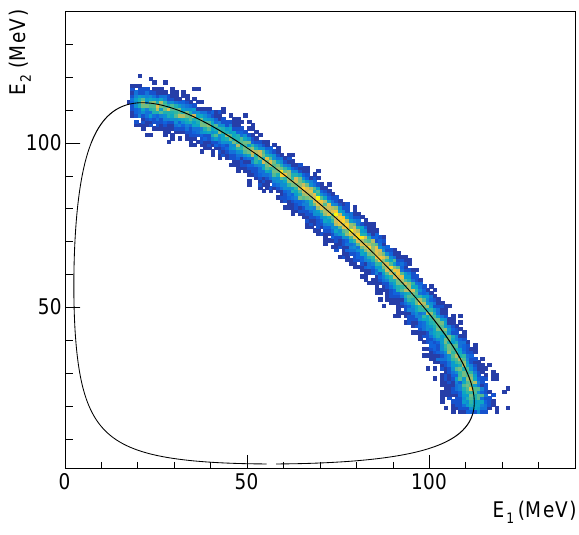
Figure 2: An example of kinematics for (d(160 MeV) + p → p + p + n) reaction at α = 20 ◦ . Selection of polar and azimuthal angles implies strict kinematic relation between kinetic energies of emitted